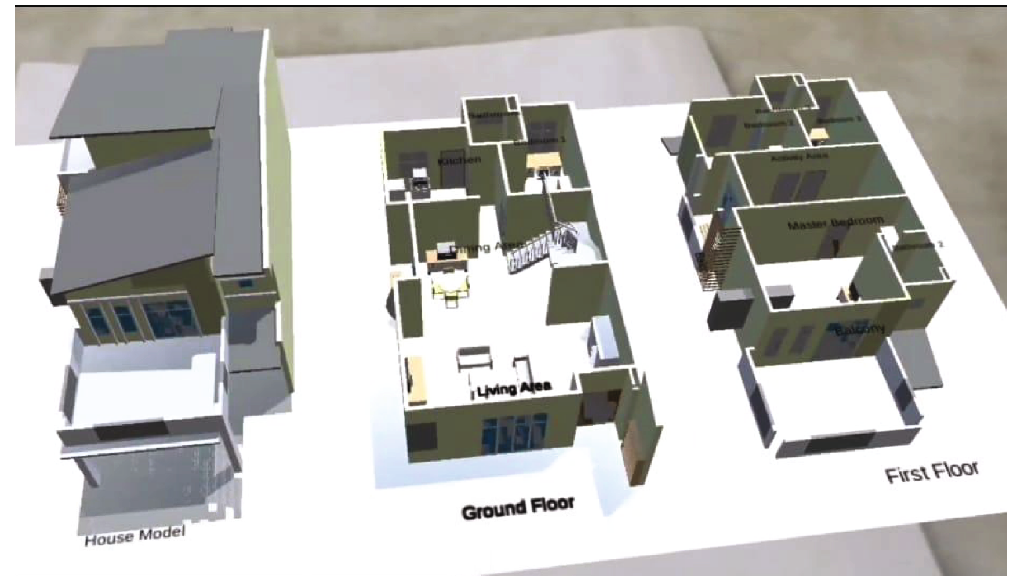
Figure 4: Housing model in AR